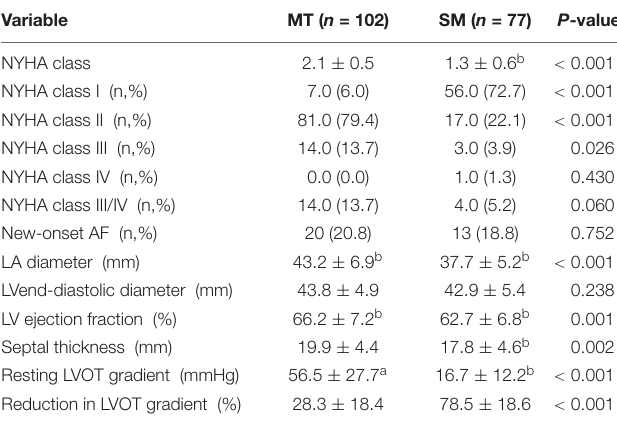
TABLE 5 | Clinical and echocardiographic characteristics of 179 mildly symptomatic patients with HOCM at the last